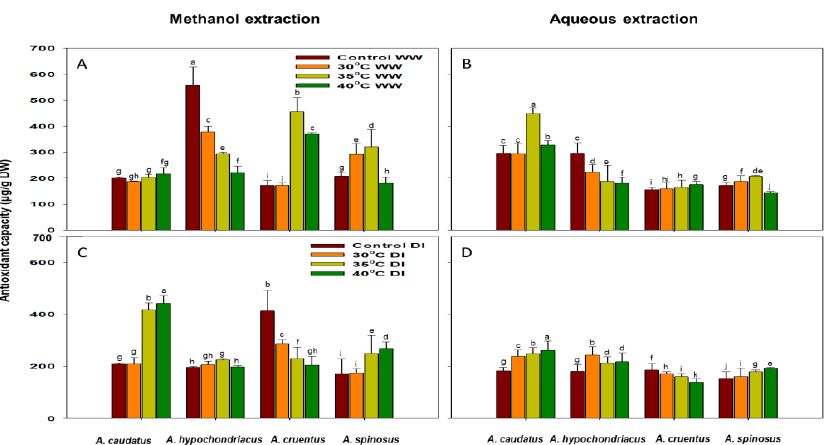
Figure 2. The effects of 30 °C, 35 °C and 40 °C temperature regimes under well-watered (WW) ( A , B ) and water-stressed (DI) ( C , D ) conditions on the accumulation of total antioxidant capacity (TAC) of A. caudatus , A. hypochondriacus , A. cruentus and A. spinosus . Each vertical bar represents the mean value, and vertical line is a mean standard error ( ± ) at 95% confidence level. Values among each species with the same letter(s) are not significantly different at p ≤